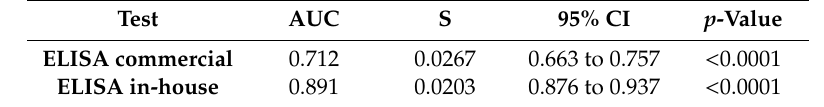
Table 3. Serological reactivity parameters used for the determination of anti- Plasmodium falciparum antibodies by in-house